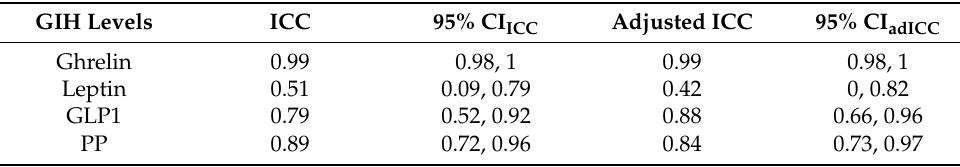
Table 4. ICC(A,1) and adjusted ICC for all fasting GIH levels (all N = 17).